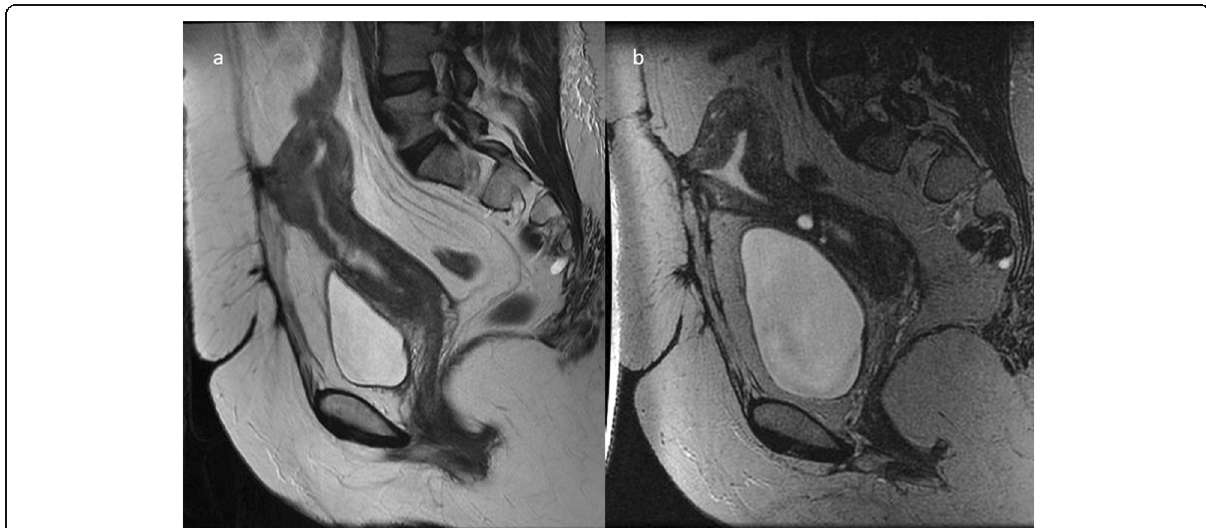
Fig. 9 Pelvic MRI in the sagittal plane. FSE/T2WI ( a ). CUBE/3D/T2WI ( b ). Thick hypointense adhesions between the abnormally flexed uterus and an anterior abdominal wall